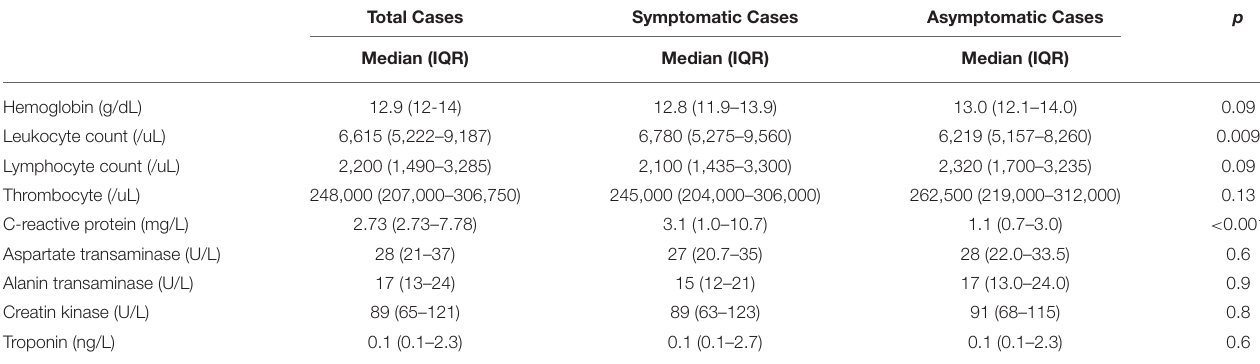
TABLE 6 | Laboratory findings.